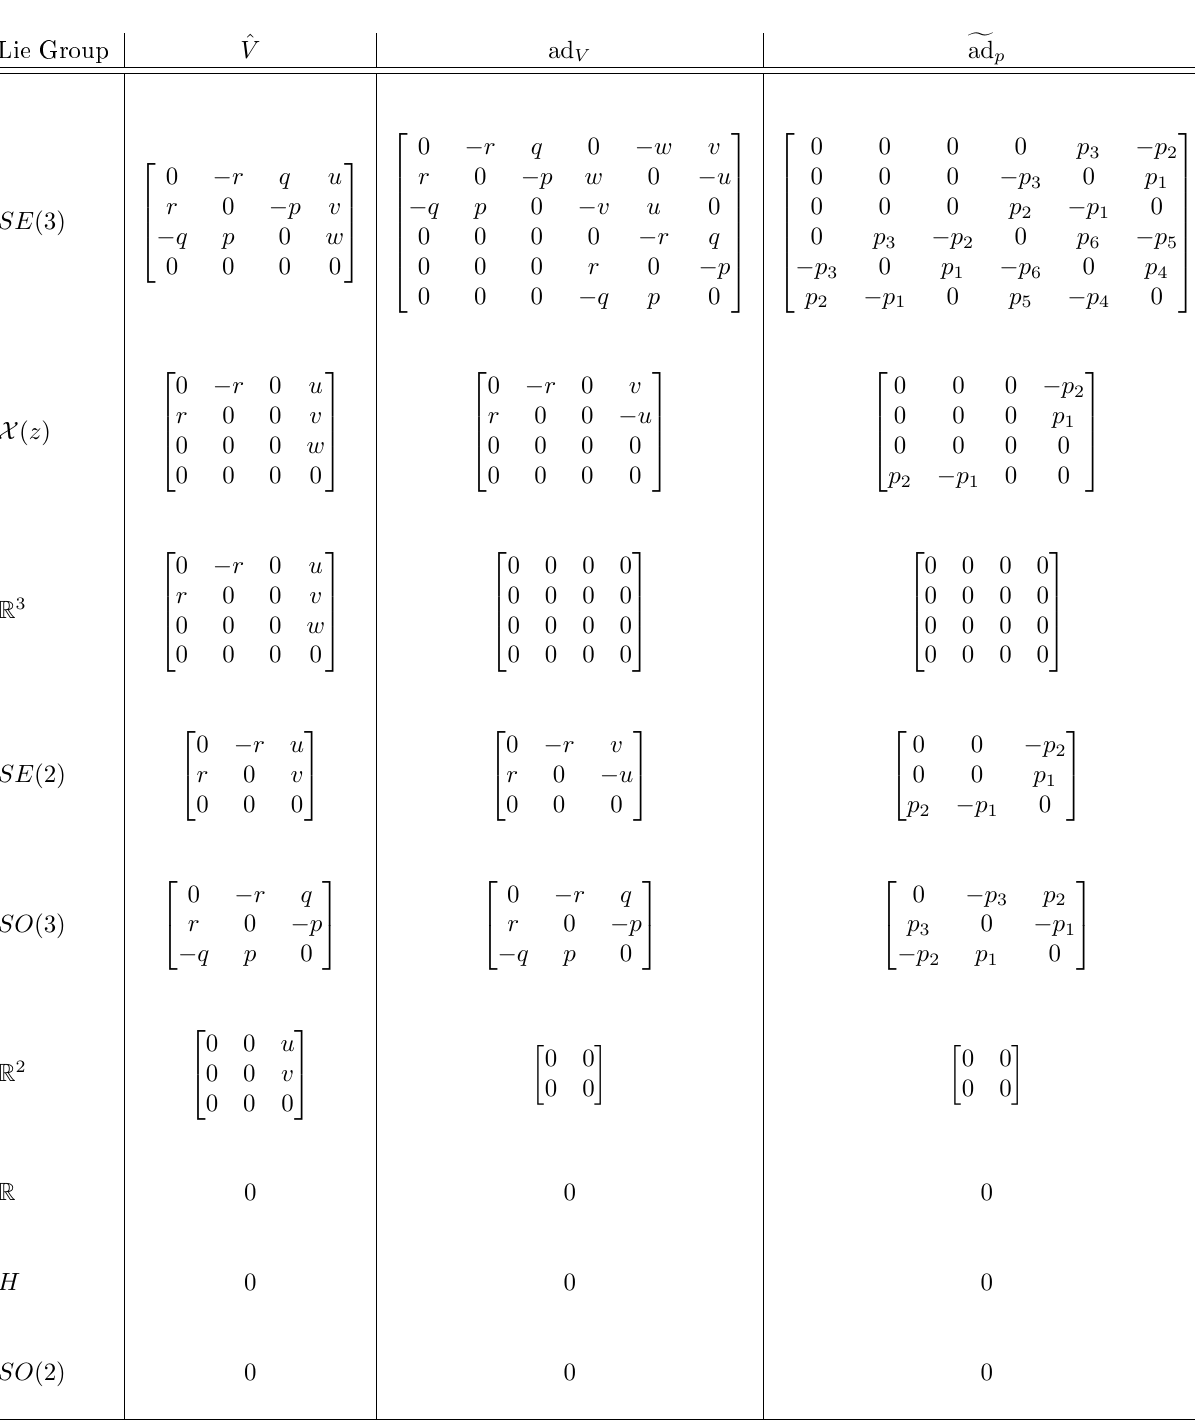
Table 1: The Lie algebras ˆ V , adjoint maps ad V and the Coriolis matrices C = (cid:102) ad p . In this paper the entries in the adjoint maps (cid:102) ad p are given by p = ( Mv )